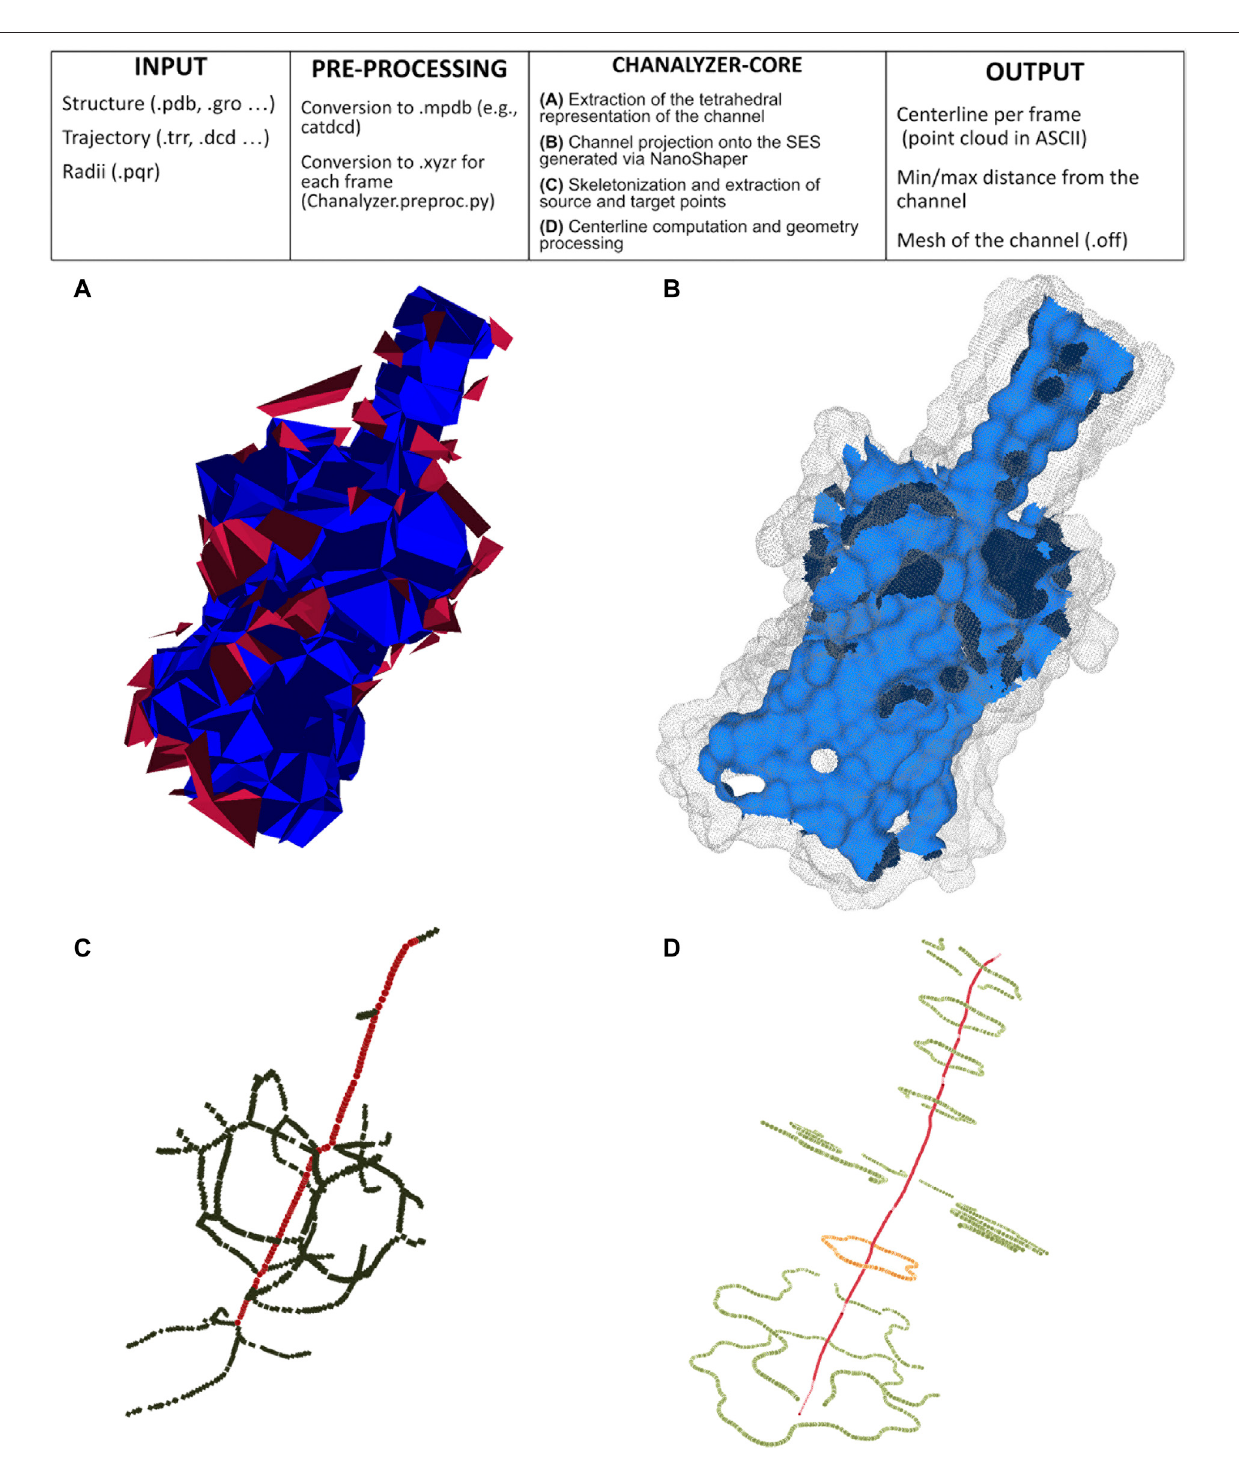
FIGURE 1 | Pipeline of Chanalyzer. At the top, the basic fl ow is described. (A) Identi fi cation of the connected components of tetrahedra that are not entirely inside theSES.Eachcomponentrepresentsacavity(inbluethelargestone,ascribedtothechannel,inredtheotherones,whicharediscarded); (B) theintersectionoftheblue component withthe SES identi fi es thechannel surface; (C) skeletonization (in green) revealing afootprint ofthe pentameric structure and the source-targetpath (in red); (D) centerline in red and several sections (in orange the central one).